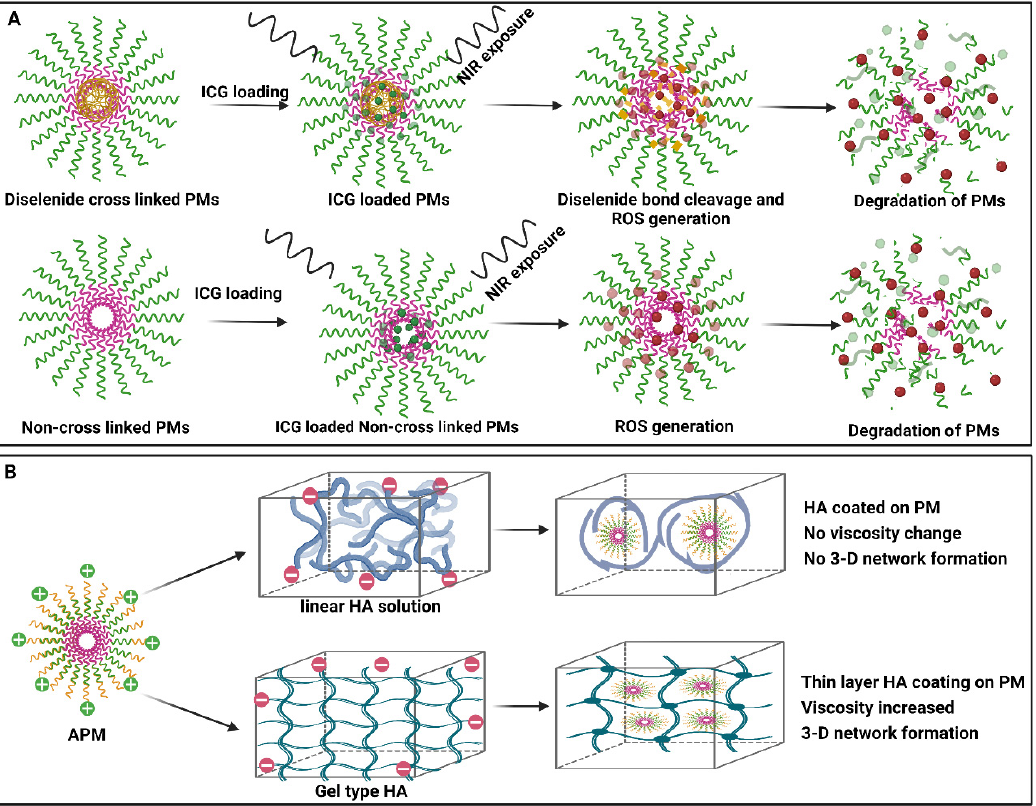
Figure 3. ( A ) Effect of exposure of NIR light on core cross-linked and non-core cross-linked polymeric micelles. ( B ) Application of electrostatically attractive PMs on the rheology of HA gel and solutions.